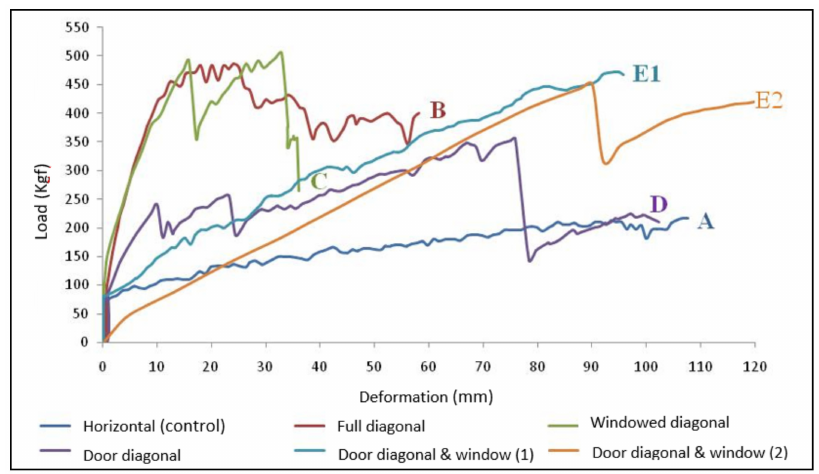
Figure 9. Graph of load response comparison—shear wall component